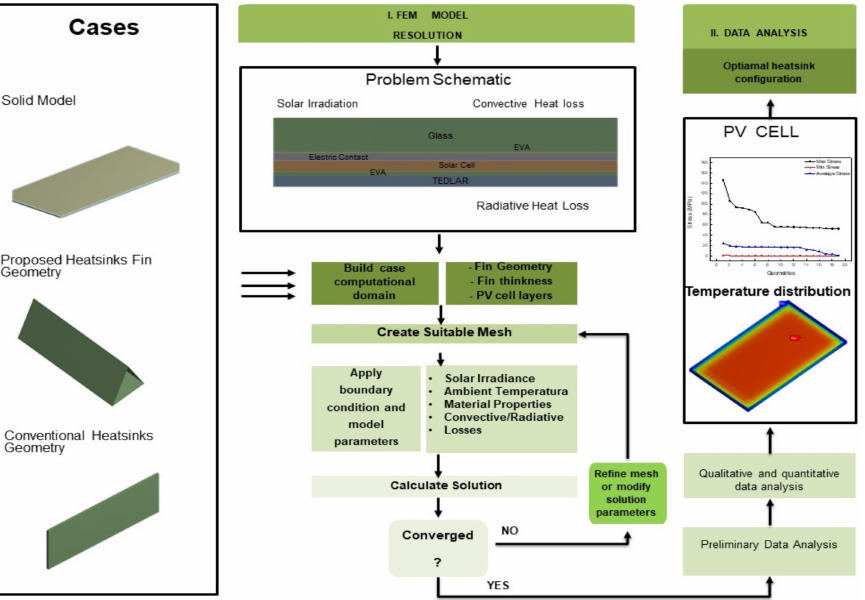
Figure 1. Flow chart which depicts the methodology used for decreasing the operational temperature in a solar